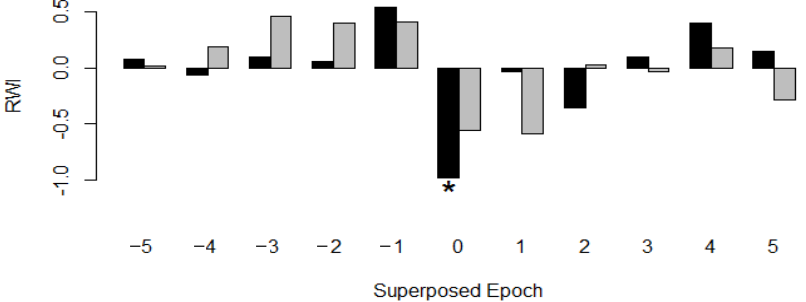
Figure 6. Drought year analysis (superposed epoch analysis) of the ring width index (RWI) during drought years (0), pre ‐ drought ( − 5 to − 1) and after drought (1 − 5) for Robinia pseudoacacia (black) and Tilia cordata (gray) in München. Input drought years are 2004, 2003, 1998, 1992, 1982, and 1976 for R. pseudoacacia and 2004, 2003, 1998, 1992, 1982, and 1976 for T. cordata . Marked columns (asterisk) represent a departure that is greater than would have occurred randomly as determined from 1000 bootstrap simulations at p < 0.05.